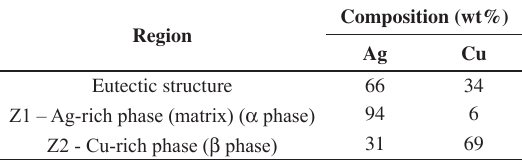
Table 2. Chemical composition of the phases present in the hot pressed sterling silver compacts. Processing conditions: 700 °C; 30